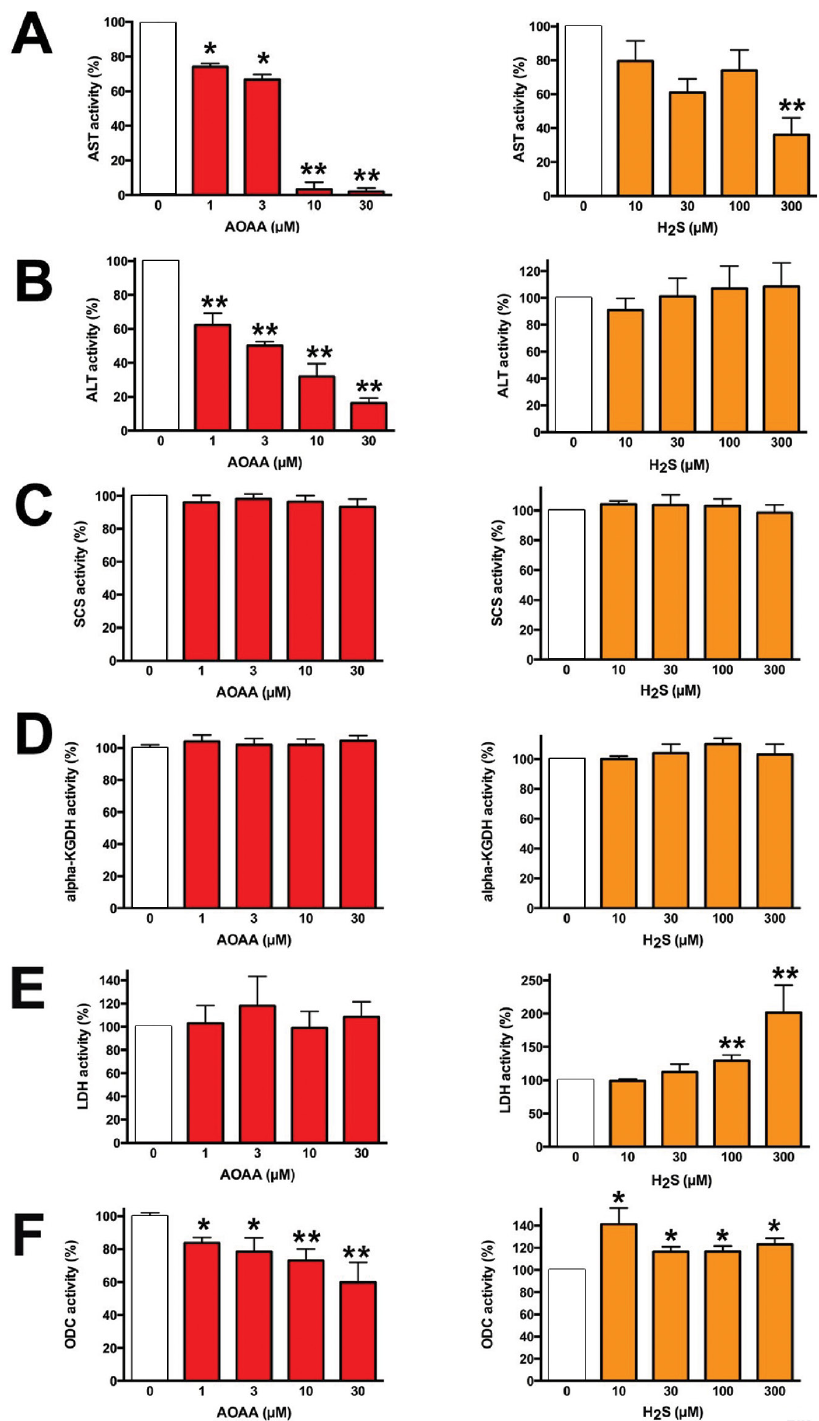
S on selected enzyme activities in vitro . Effect Figure 8. Direct effect of AOAA or H 2 of AOAA or H S (produced as NaHS) on the enzymatic activity of (A) AST/GOT1, 2 (B) ALT, (C) SCS (D) α -ketoglutarate dehydrogenase (E) LDH and (F) ODC. Data shown as mean ± SEM; n = 3–6; * p < 0.05 and ** p < 0.01 indicate significant effects of AOAA or H S compared with 2